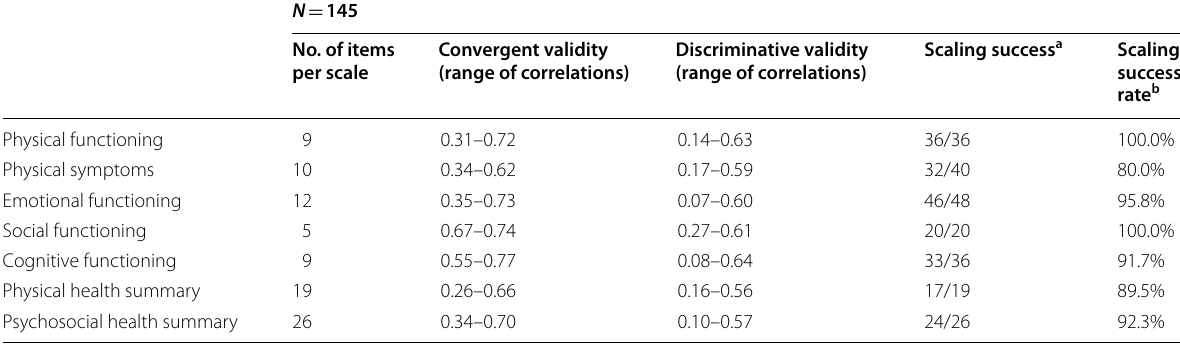
Table 5 Factorial validity of the Japanese version of the PedsQL Infant